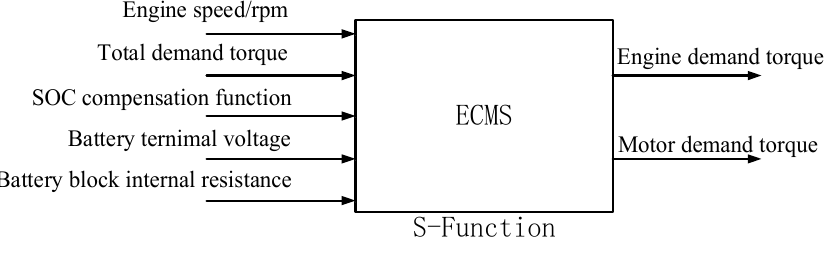
Figure 5. Energy management control strategy map.